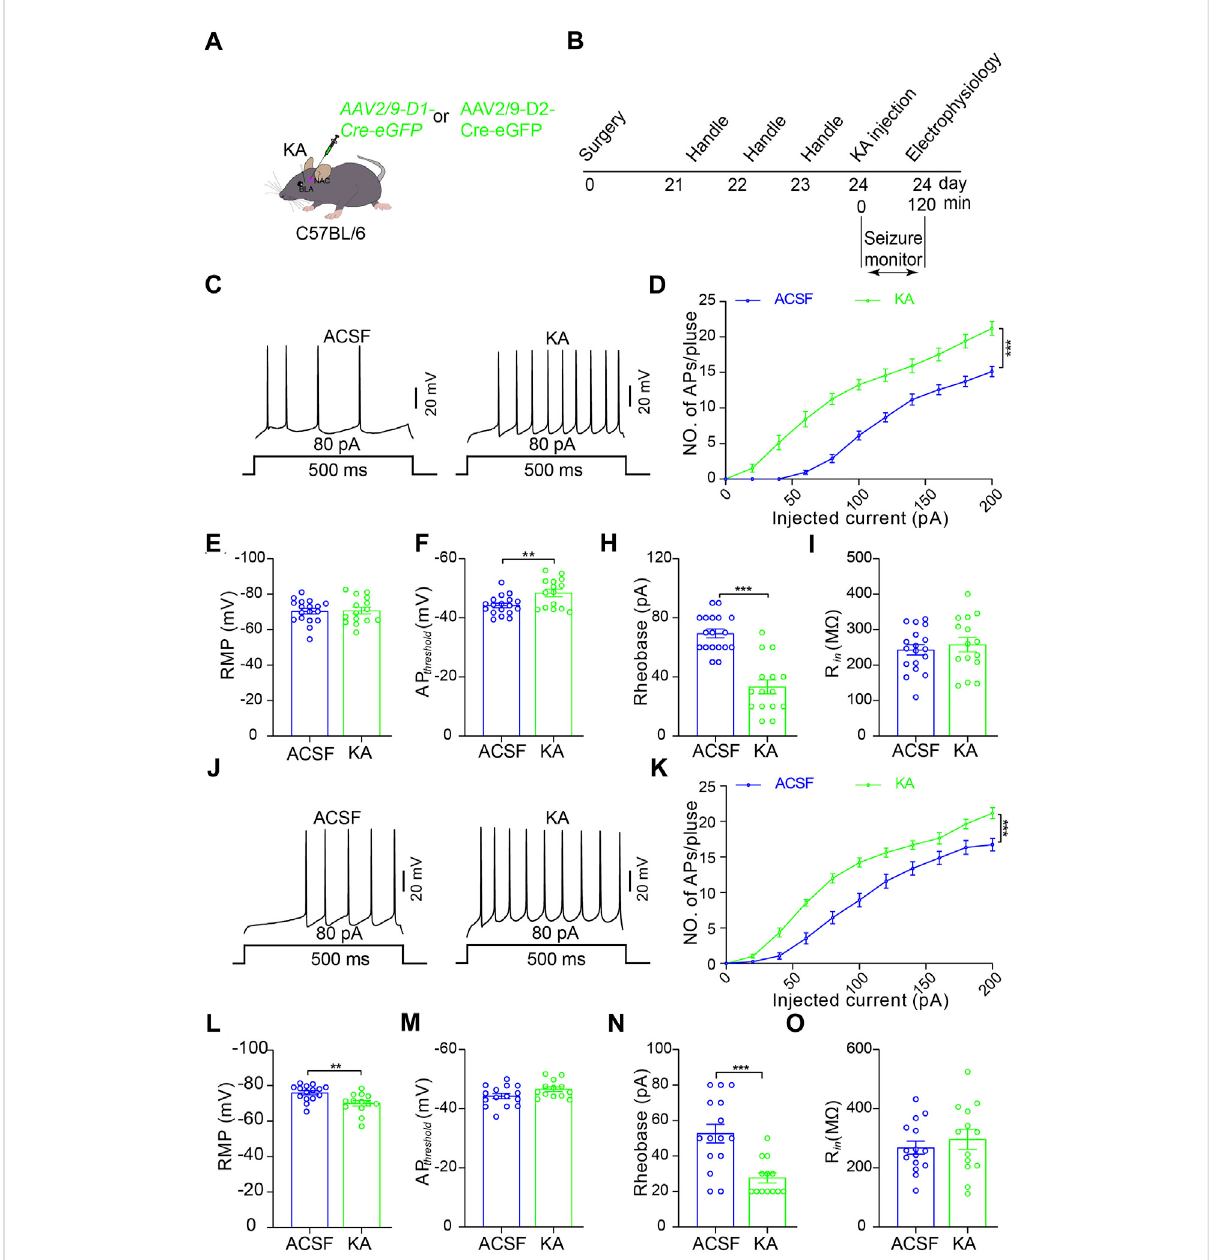
Increased excitability of D1R- and D2R-MSNs in the NAc shell after TLE seizures. (A) Schematic diagram of virus microinjection to enable expression of eGFP reporter on D1R-MSNsor D2R-MSNs in the NAc shell and KA microinjection into BLA to induce TLE seizuresof C57BL/6 mouse. (B) Schematic diagram of TLE seizure induction followed by in intro electrophysiological recording in the NAc shell. (C) Representative current- clamp recordings. (D) Summary input – output curves of D1R-MSN of the mice treated KA ( n = 15 cells) show increased AP generations in response to current injections, comparing with the control mice treated with ACSF ( n = 18 cells). *** p < 0.001, F = 70.049, df = 1, two-way ANOVA withTukeypost-hoctest. (E – I) Summarydataofrestingmembranepotential(RMP),APthreshold,rheobasecurrent,andmembraneinputresistance (R in )ofD1R-MSNofthemicetreatedwithACSF( n =18cells)orKA( n =15cells).** p < 0.01,*** p < 0.001,Student ’ sunpairedt-test. (J) Representative current-clamprecordingsand (K) summaryinput – outputcurvesofD2R-MSN ofthemicetreated KA( n =13cells)showincreasedAP generationsin responsetocurrentinjections,comparedwiththecontrolmicetreatedwithACSF( n =15cells).*** p < 0.001,F=20.136,df=1,two-wayANOVAwith Tukey post-hoc test. (L – O) Summary data of resting membrane potential (RMP), AP threshold, rheobase current, and membrane input resistance (R in ) of D2R-MSN of the mice treated with ACSF ( n = 15 cells) or KA ( n = 13 cells). ** p < 0.01, *** p < 0.001, student ’ s unpaired